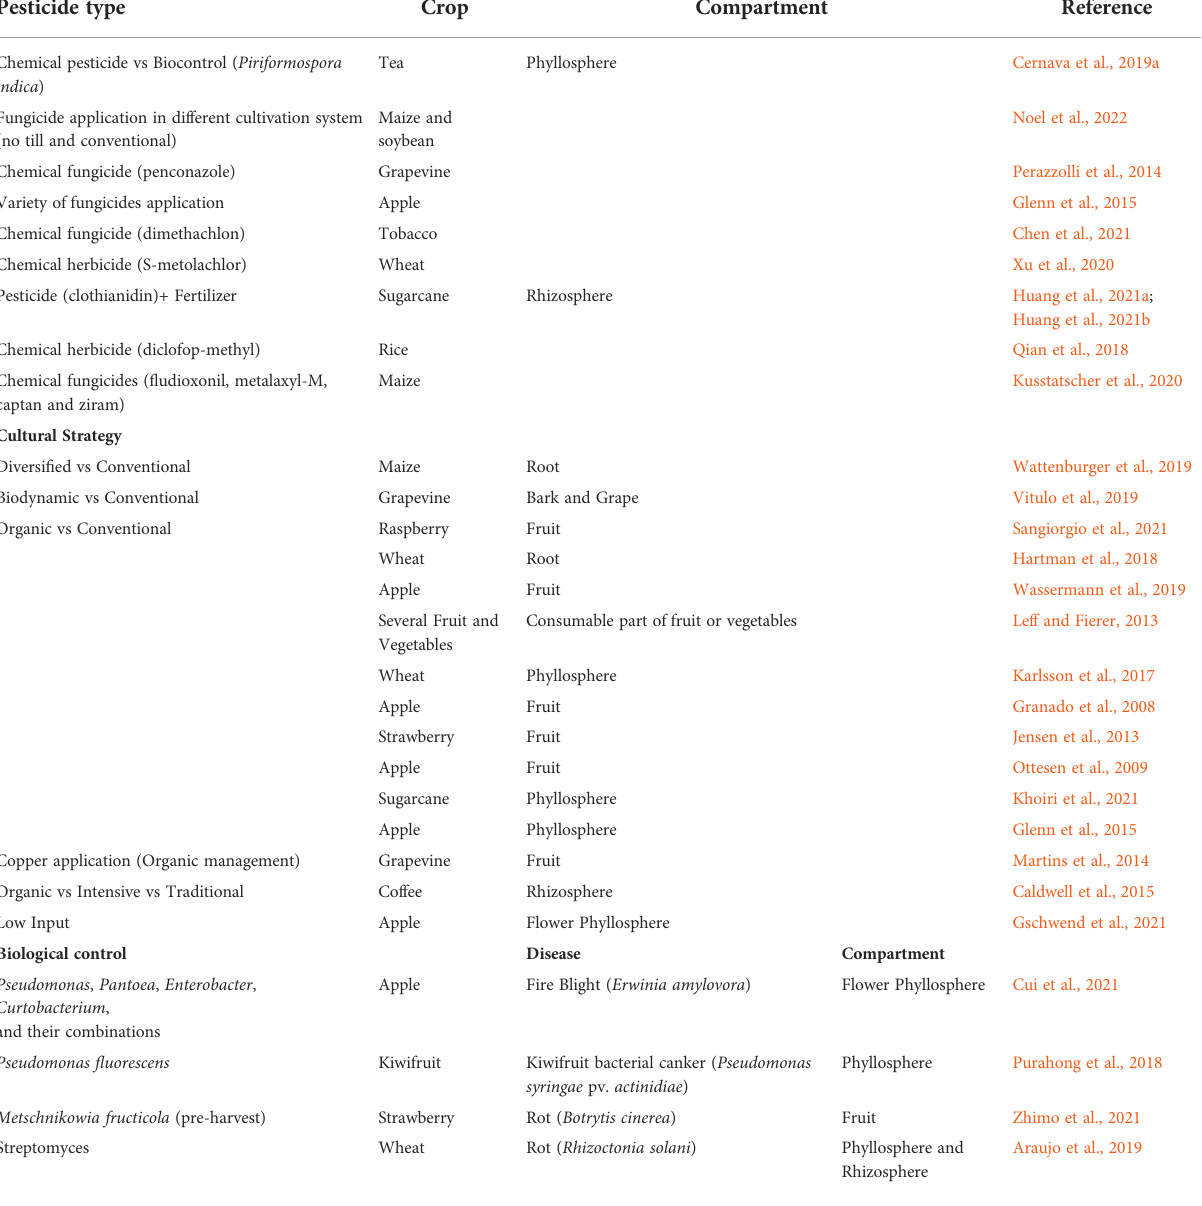
TABLE 1 List of research works focusing on the in fl uence of chemical and biological pesticide or agricultural management strategies on phytobiota. Pesticide type Crop